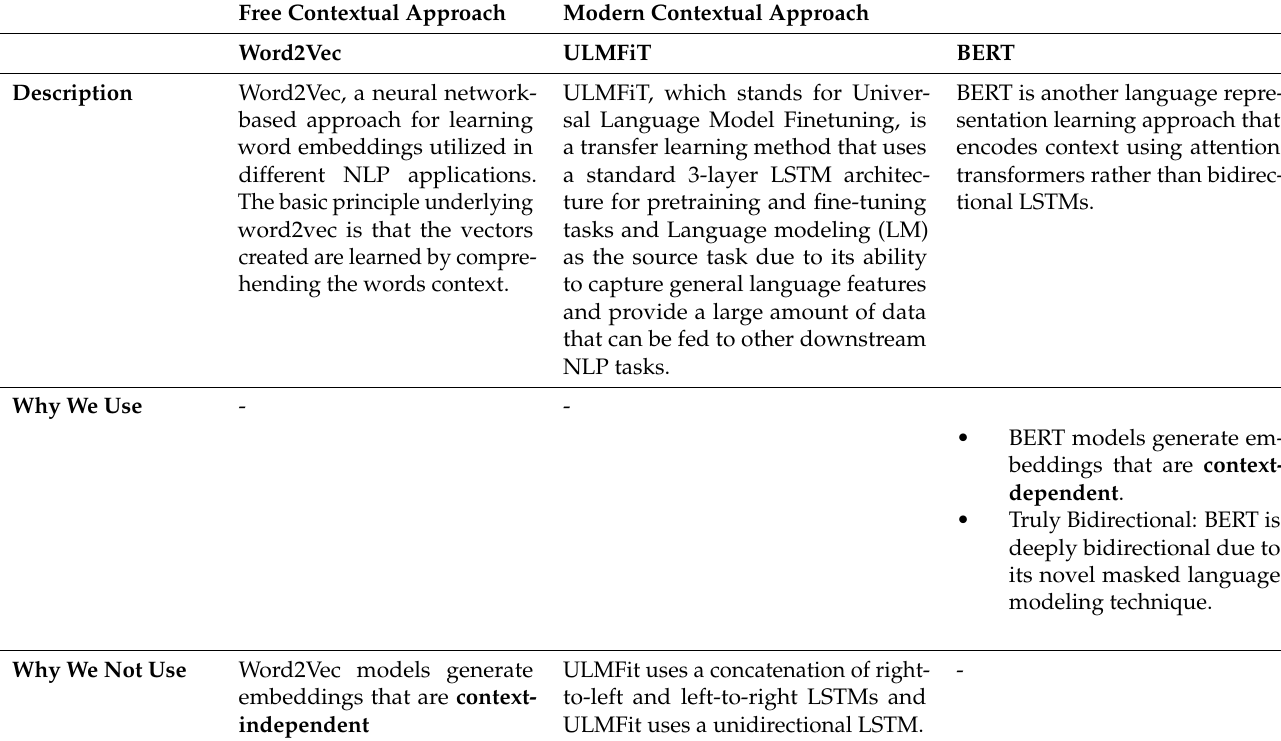
Table 3. Comparison between contextual